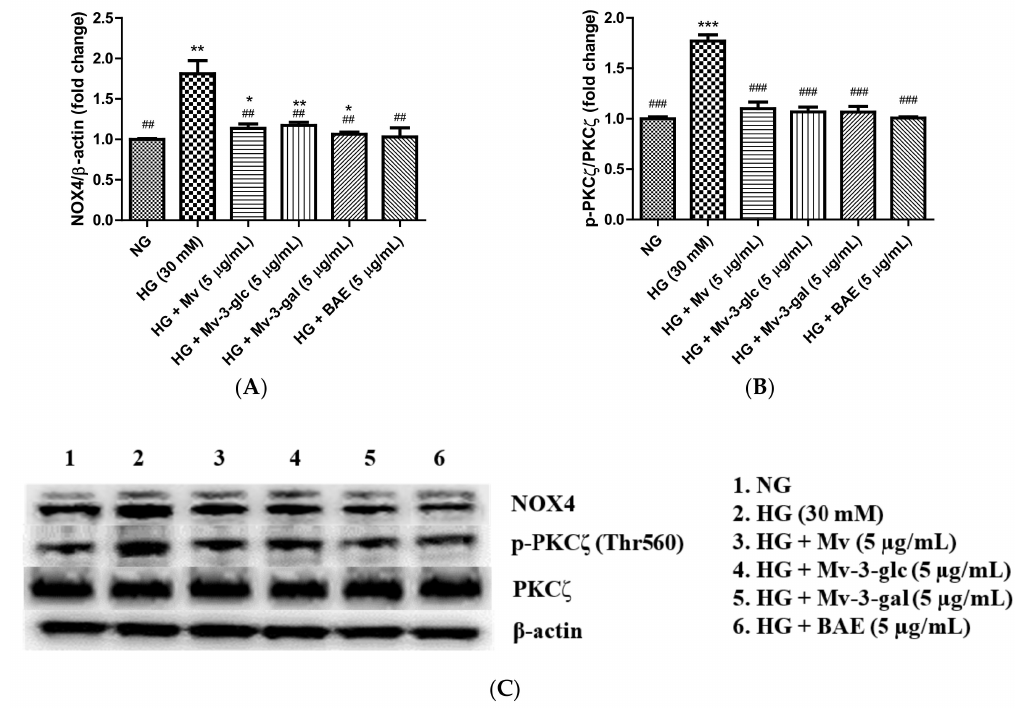
Figure 5. Downregulatory e ff ects of Mv, Mv-3-glc, Mv-3-gal, and BAE on ( A ) NADPH oxidase isoform 4 (NOX4) and ( B ) p-PKC ζ / PKC ζ levels in HUVECs exposed to high glucose for 24 h. ( C ) Representative western blot bands are shown. Bars represent mean values ± SD ( n = 3). *, **, and *** indicate p < 0.05, p < 0.01, and p < 0.001, respectively, compared with the control NG; ## and ### indicate p < 0.01 and p < 0.001, respectively, compared with the HG